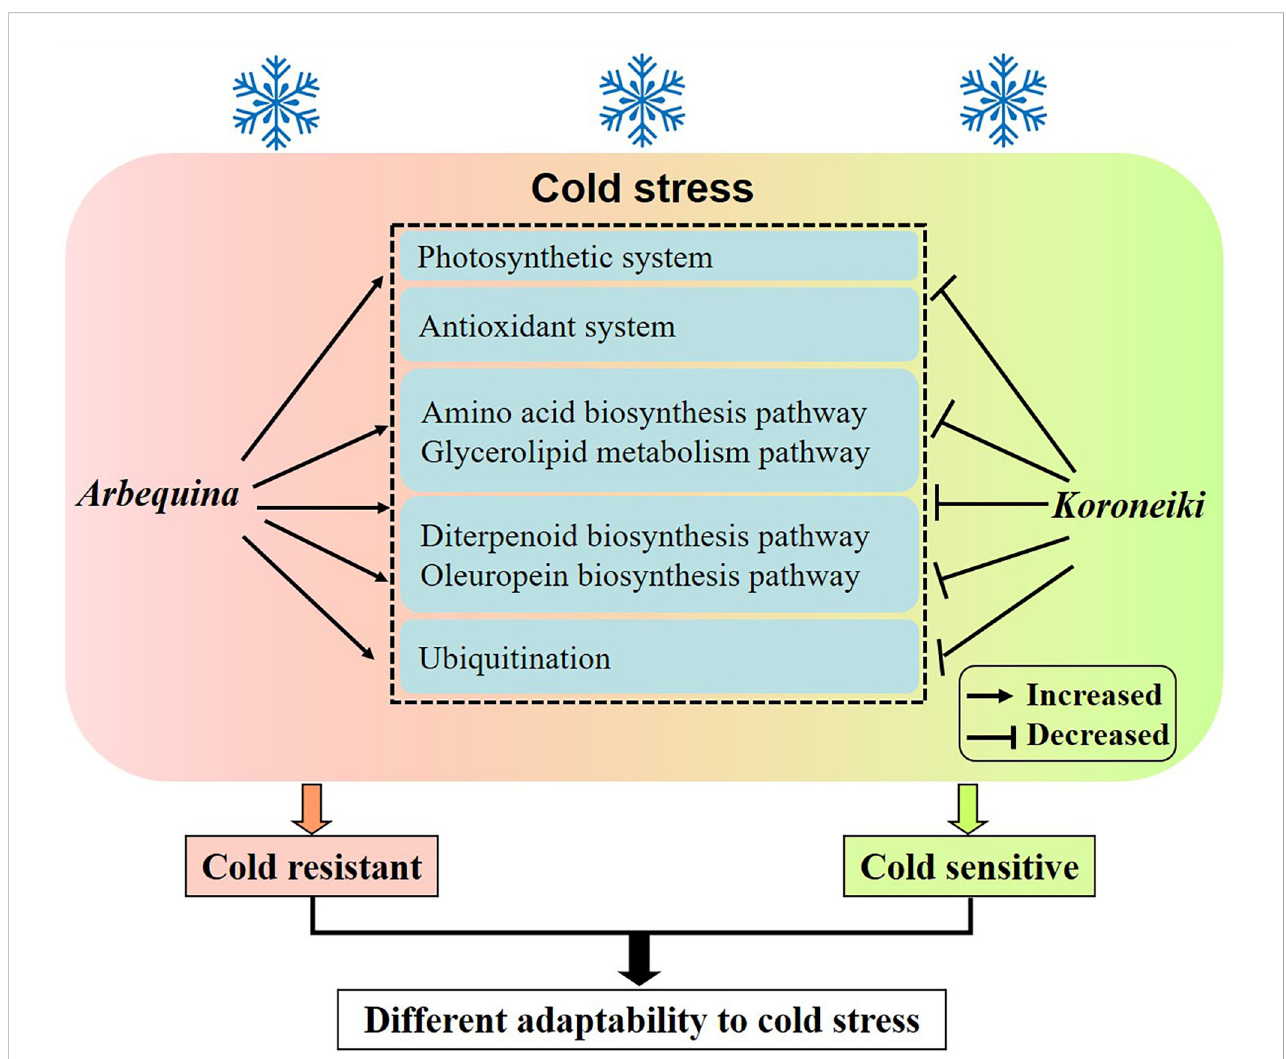
FIGURE 7 A proposed model for cold resistance in